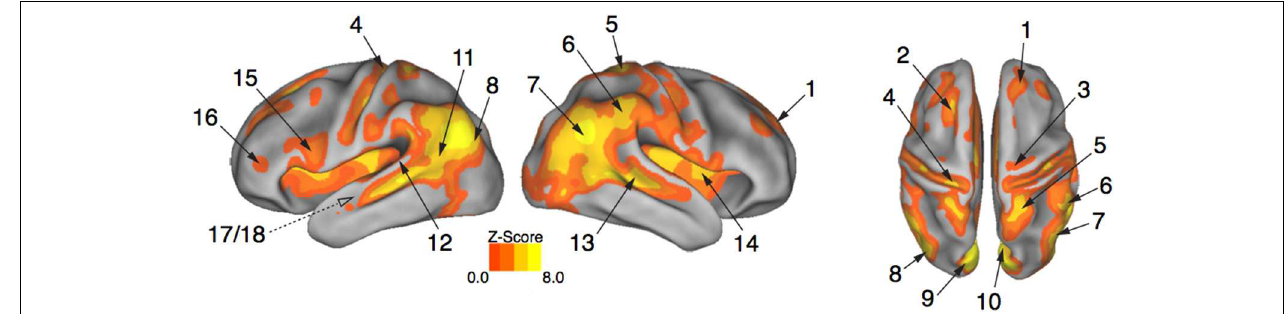
“mirror neuron” system, as well as non-motor areas linked to comprehension, social perception, and affective decision-making. Number labels correspond to those listed in Table 2 , which provides anatomical names and voxel coordinates for areas of peak activation. Dotted line for regions 17/18 indicates medial temporal position not visible on the cortical surface.